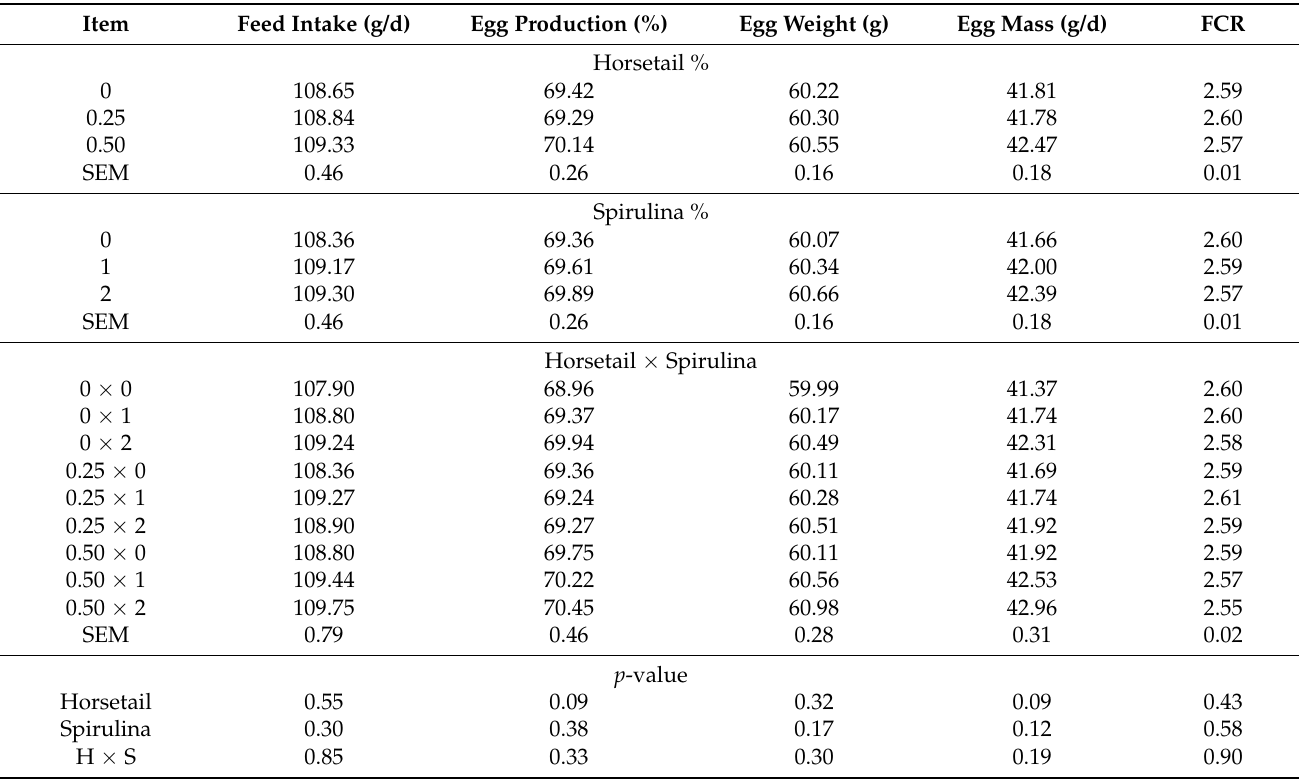
Table 4. Influence of treatments on feed intake and efficiency, and egg